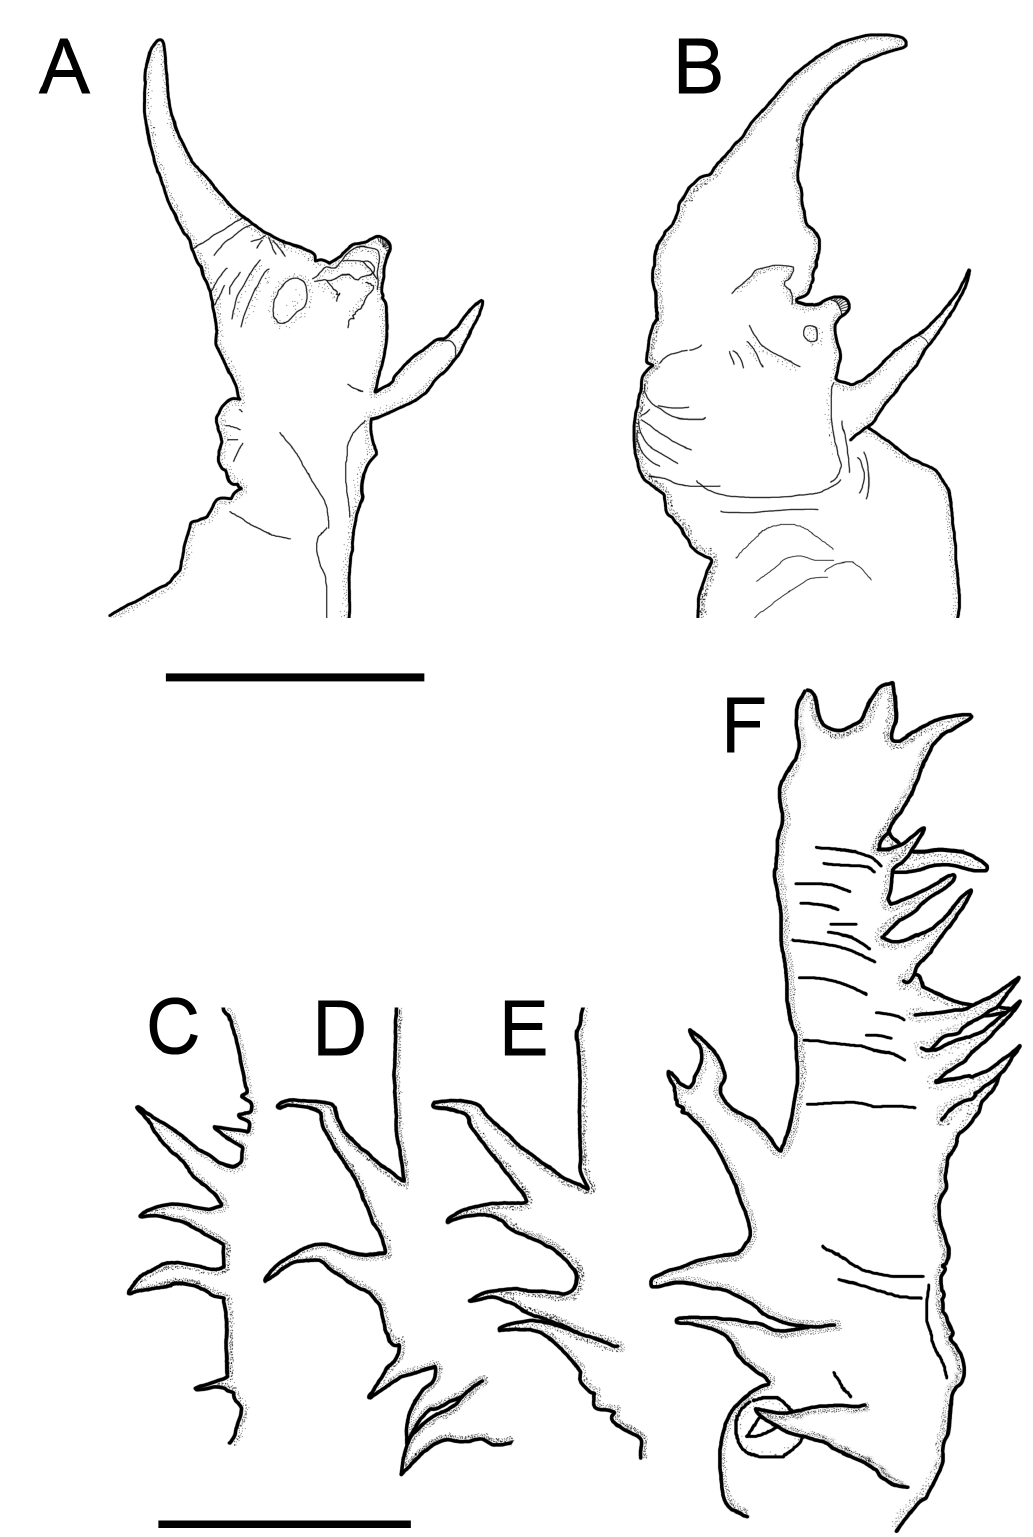
Fig. 4. Morphological variation in the frontal appendage of Dendrocephalus carajaensis Rogers, Gomes & Vieira, 2012, ♂. A–B . Branch 2A from two specimens. C–F . Sub-branch III of branch 2D from different specimens. Scale bars: 0.5